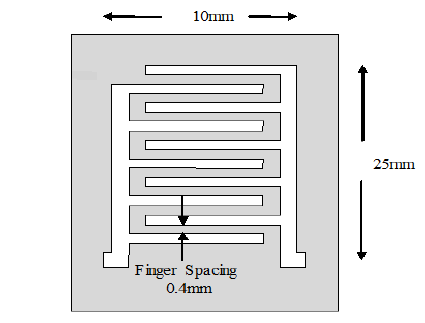
Figure 2: Schematic diagram for inter electrodes of photoconductive detector